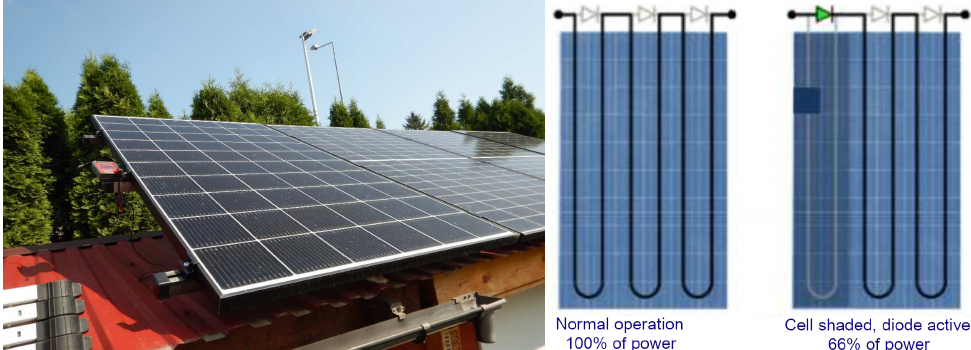
Figure 2. The PV system prepared for measurements. The tested module (LG366N1C-N5) is visible in the foreground ( left inset ). The orientation of the module is presented on the ( right inset ), which additionally explains the purpose of bypass